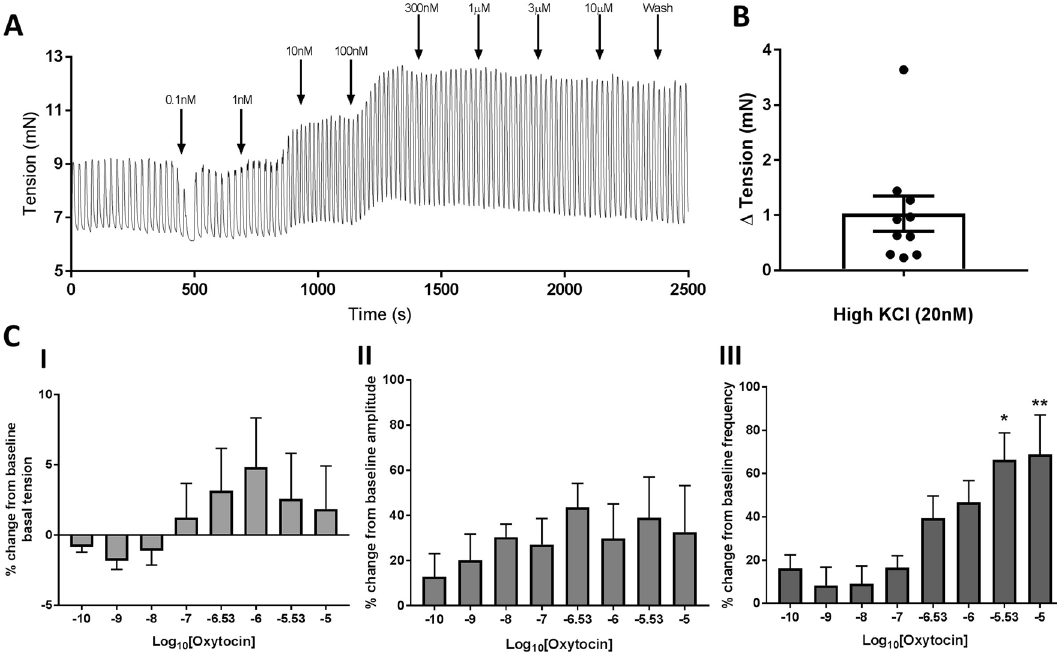
Figure 3. Application of exogenous oxytocin modulated the dynamic component by significantly increasing the frequency of spontaneous contractions within the human prostate. To assess the dynamic component, primary human prostate tissue collected from the transition zone (TZ) was exposed to increasing concentrations of exogenous oxytocin (0.1 nM–10 μM). ( A ) representative trace of spontaneous contractions following exposure to exogenous oxytocin (0.1 nM–10 μM). ( B ) Application of High KCl (20 mM) induced a robust contraction following conclusion of the dose response curve, confirming tissue viability. The percentage change (% change) from baseline (I) basal tension, (II) amplitude and (III) frequency of spontaneous contractions following application of exogenous oxytocin (0.1 nM–10 μM) (n = 9, paired one-way ANOVA with Dunnets multiple comparisons test, * p < 0.05, ** p <